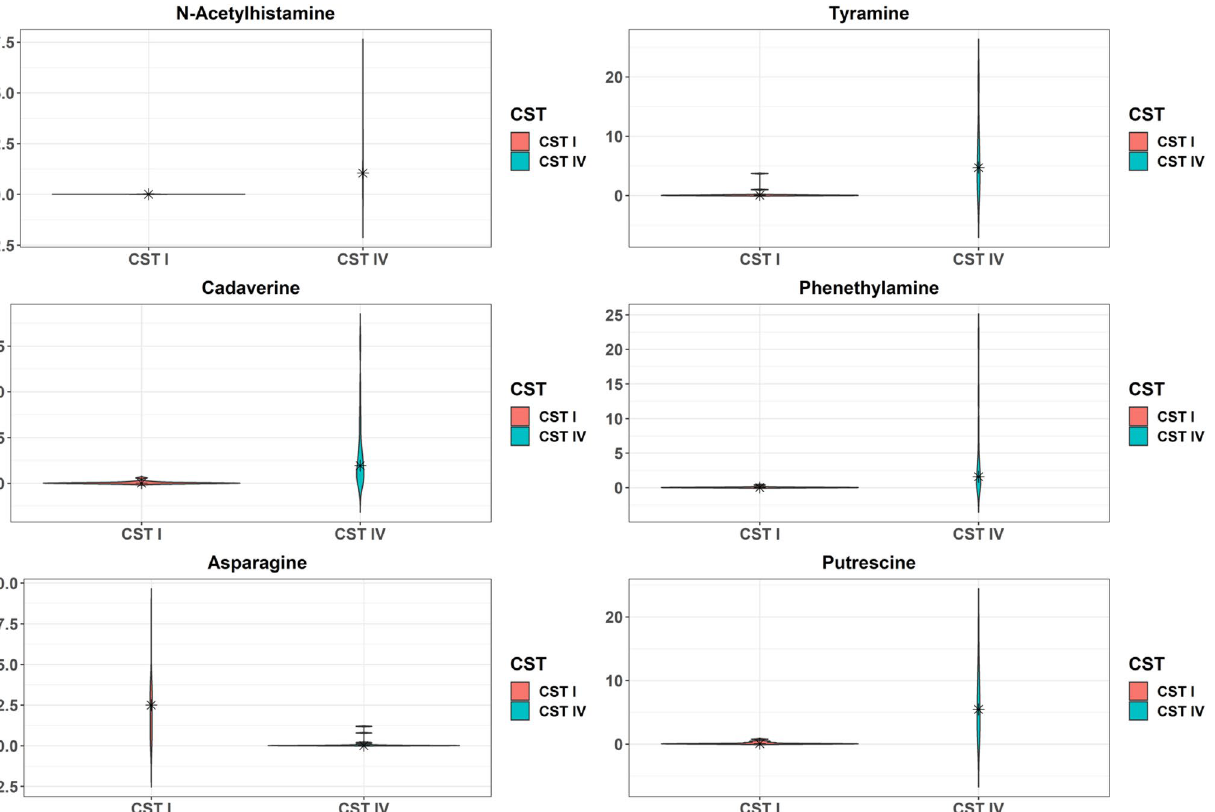
Figure 2. Violin plots of metabolites that differed by Community State Type (CST). Kernel probability density of various metabolites are presented. Metabolite abundances were log2 transformed and two-sided Student t-tests were performed. Resulting p-values were corrected by false discovery rates calculated using the Benjamini–Hochberg (BH) method with a threshold of ≤ 0.1. Fold change was calculated to quantify the difference in log2 change between groups for each metabolite. Metabolites with a p-value ≤ 0.05 and absolute fold changes ≥ 1.5 were considered significant. Violin plots are presented for the top six metabolites with the greatest fold change.